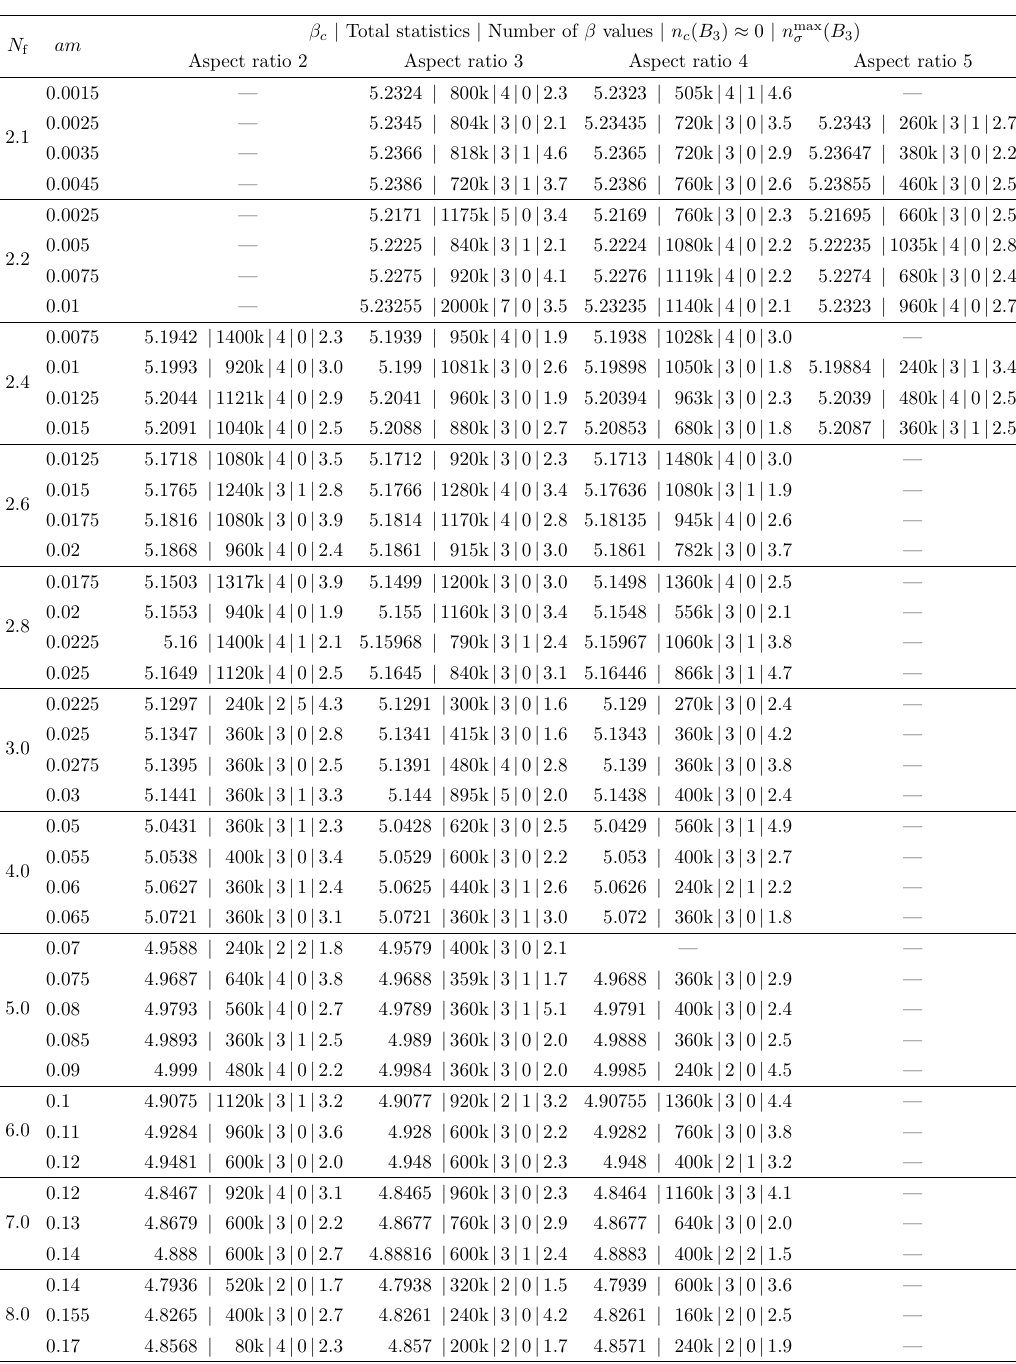
Table 8. Statistics overview for N τ = 4